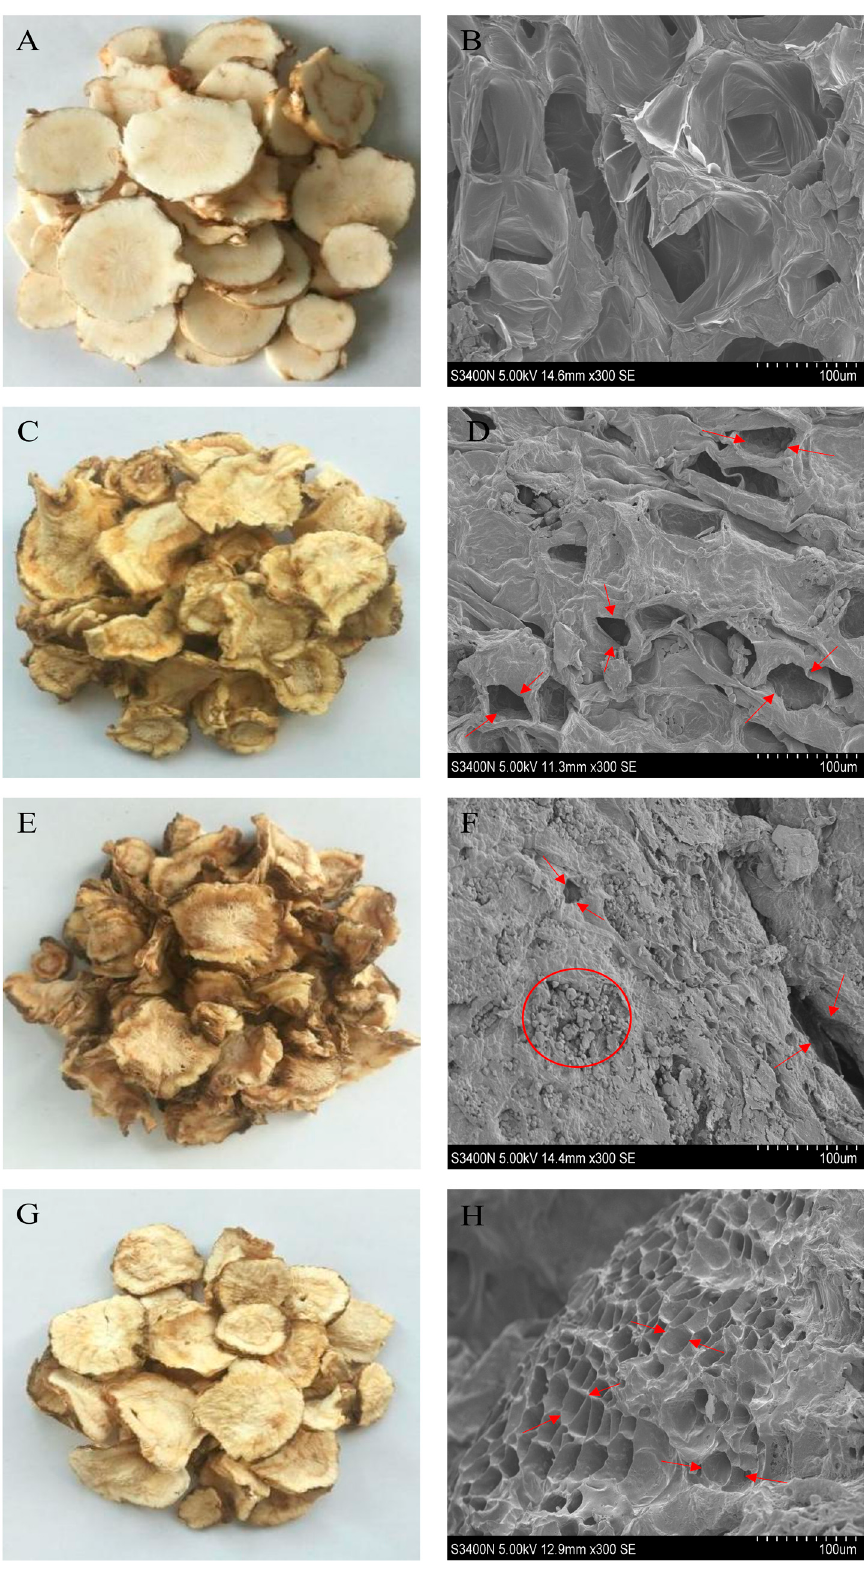
Figure 9. Macroscopic and microscopic of Angelica sinensis under different drying conditions. ( A , B